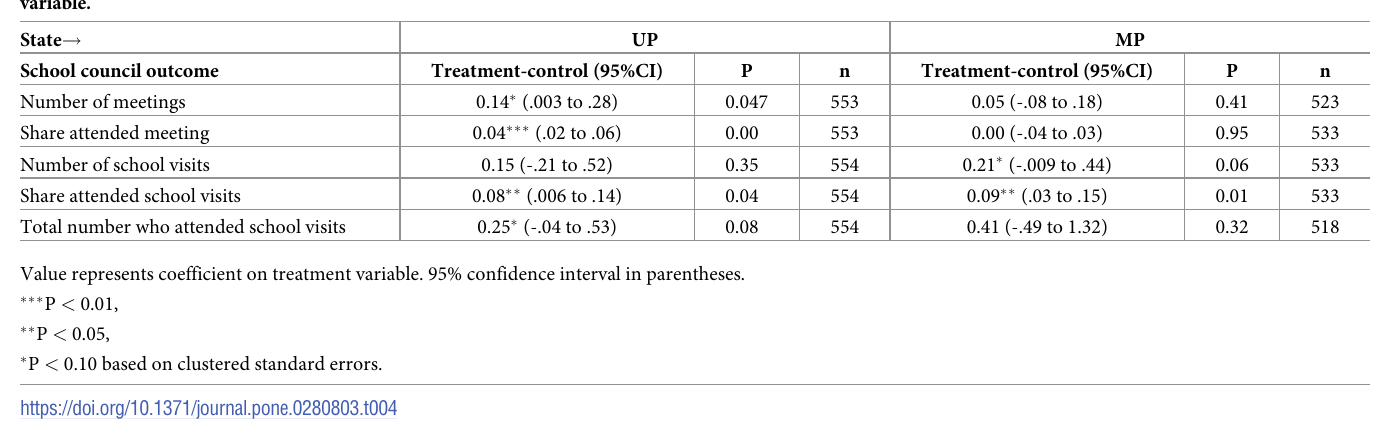
Table 4. Difference-in-differences linear regression results in MP and UP where change in school council outcome from baseline to follow-up is dependent variable. State !